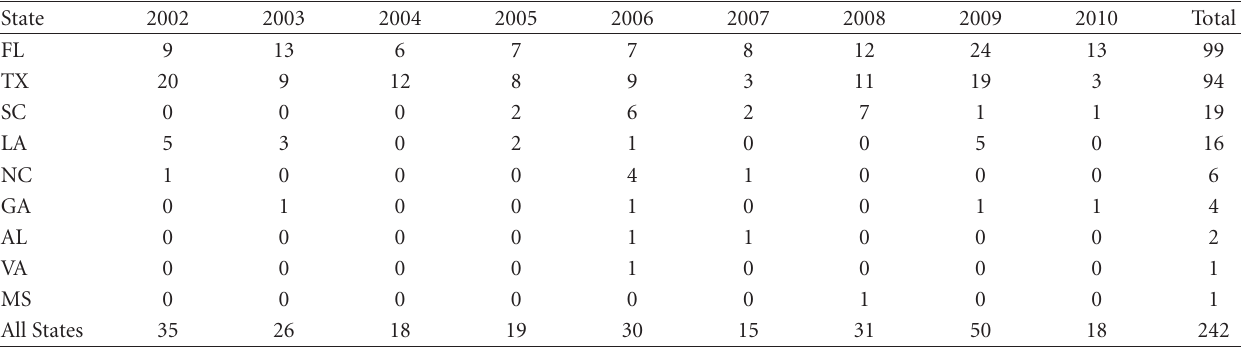
Table 1: Summary of all sightings of “overwintering” monarchs (sightings of adults and breeding activity) made during the months of January and February from 2002 to 2010, broken down by state.